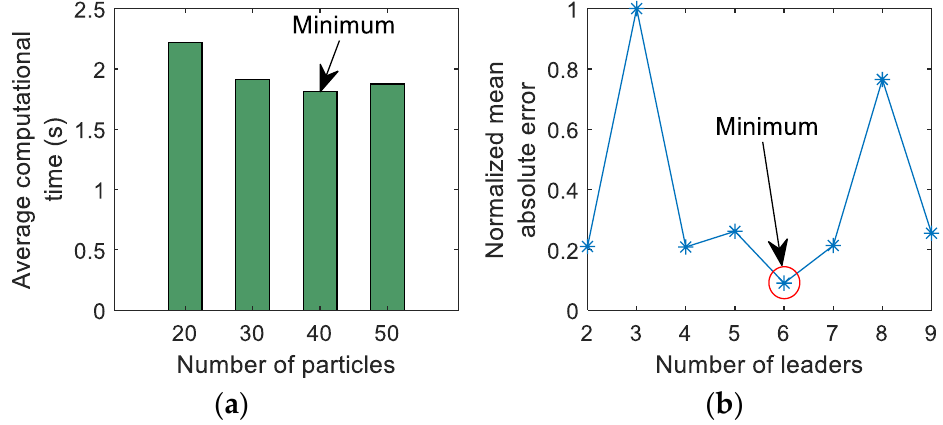
Figure 13. The ( a ) comparison of the average computational time for different number of particles ( 𝑠 ) and ( b ) mean absolute error for different number of leaders ( 𝐿 ) for the three DG scenario of IEEE 33 bus system